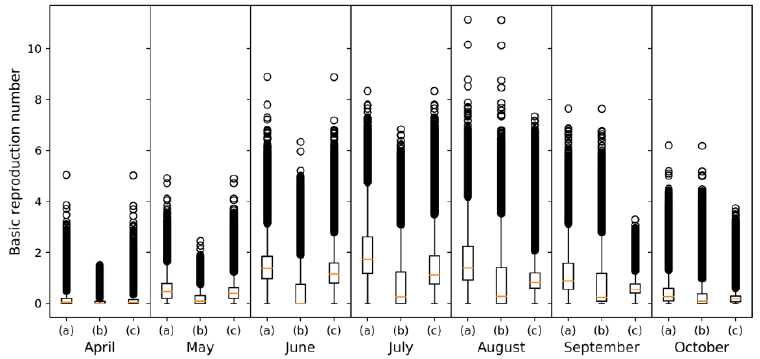
Figure 6. Monthly R 0 values for ( a ) the two-vector formulation, ( b ) one-vector formulation for C. imicola and ( c ) one-vector formulation for the Obsoletus complex species.